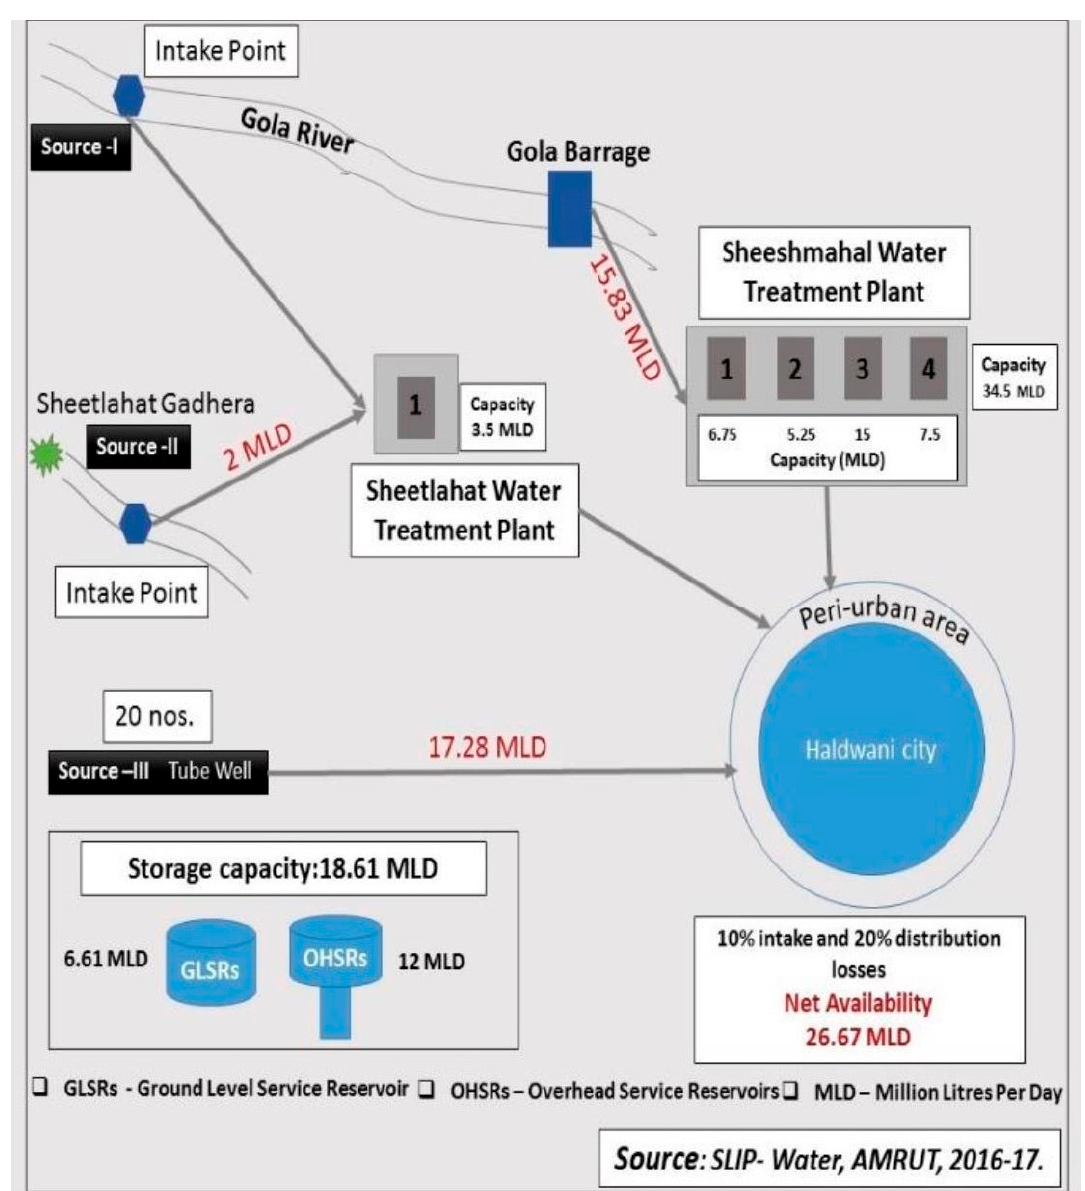
Figure 6. Water source, storage and distribution map of Haldwani.